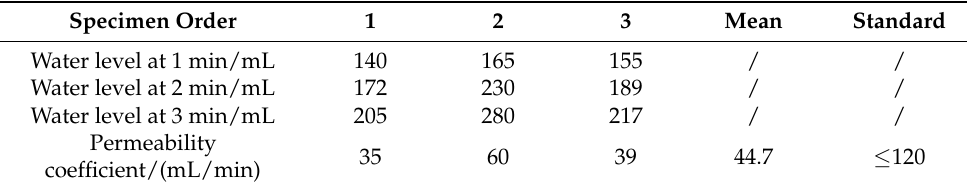
Table 14. Water permeability of SSAM.